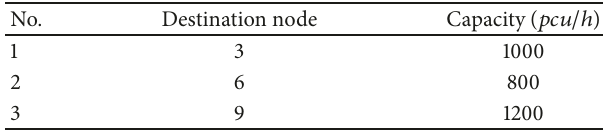
Table 3: Information of shelter capacity.